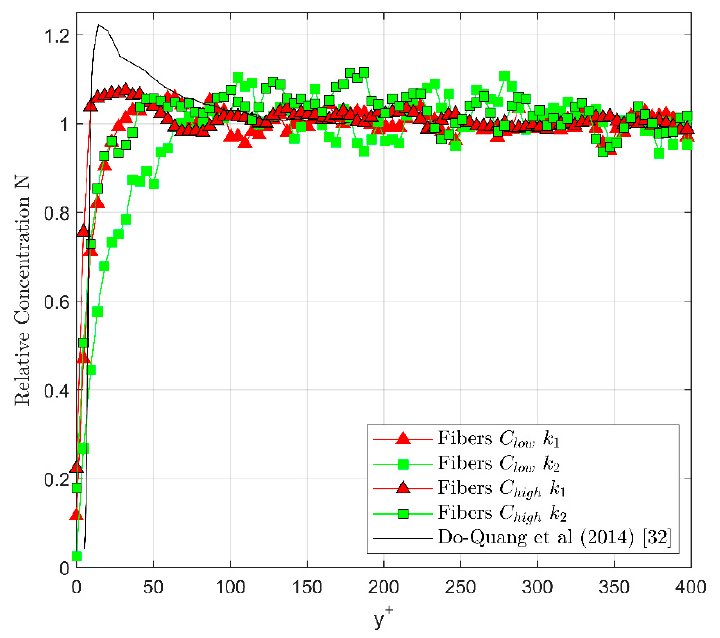
Figure 10. Relative concentration N of fiber particles normalized versus centerline concentration. Data compared to Do-Quang et al. (2014) [38].